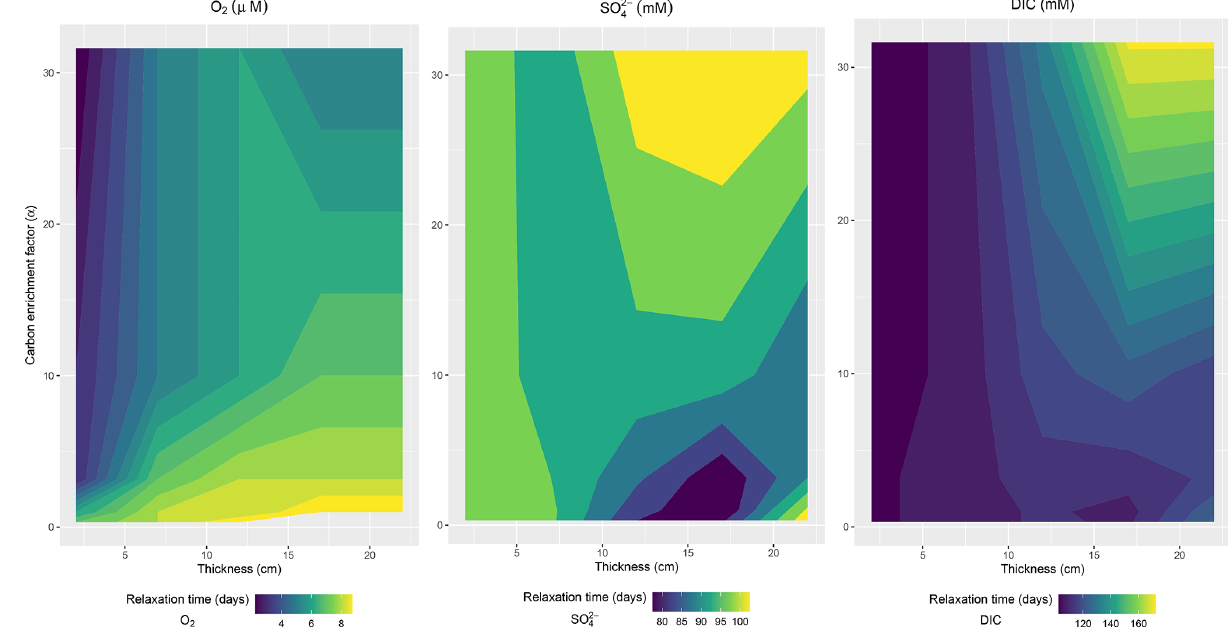
Figure 9. Relaxation timescale ( τ ) in days as function of deposited sediment thickness and enrichment factor ( α ) for degradable